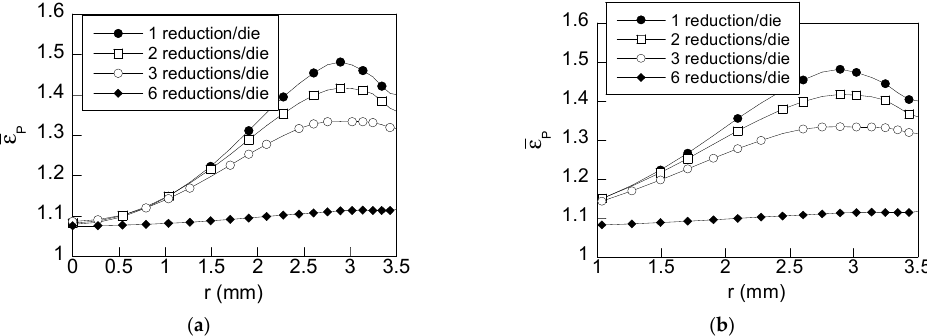
Figure 6. Radial distribution of equivalent plastic strain: ( a ) general view; ( b ) detailed view of the important near-surface region of the wire.